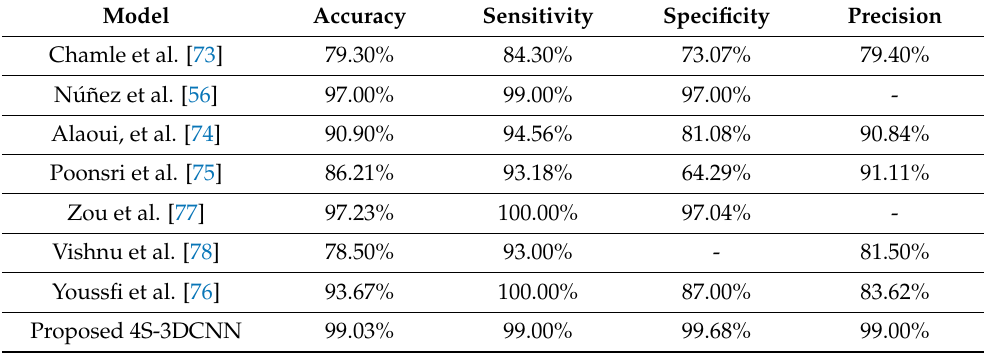
Table 6. Comparison of the proposed 4S-3DCNN with similar works on the Le2i